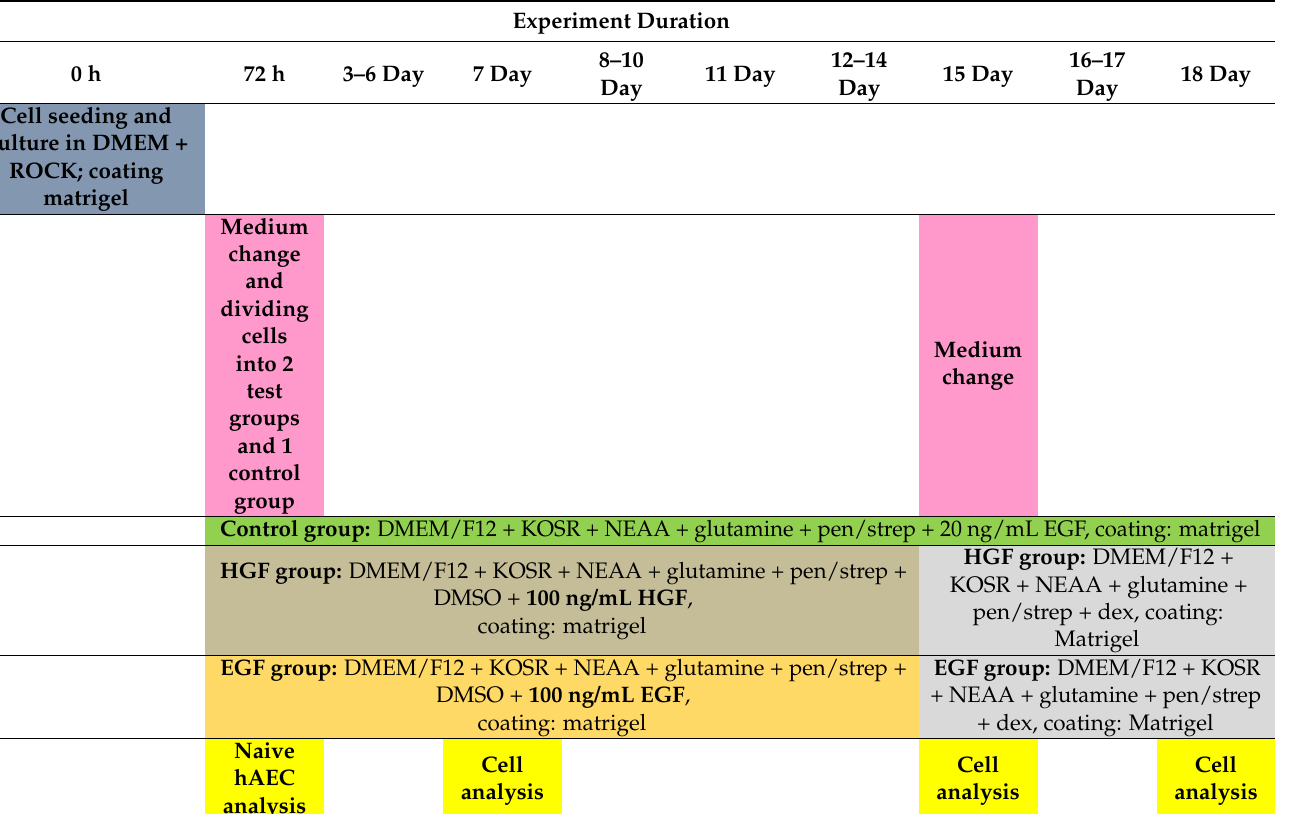
Table 1. The two-stage hAECs differentiation protocol used to differentiate hAECs into liver cells. The cell analysis included cell count and viability using the ApoFlowEx FITC Kit (FACS); percentage of cells expressing the pluripotency marker and mesenchymal markers (FACS); percentage of cells capable of producing epithelial cell-specific proteins, hepatoblasts, hepatocytes, and cholangiocytes (ICC); expression of 13 genes characterising the degree of hAEC differentiation; and ability to synthesize and secrete albumin into the culture medium (ELISA) and to synthesise and store glycogen (PAS